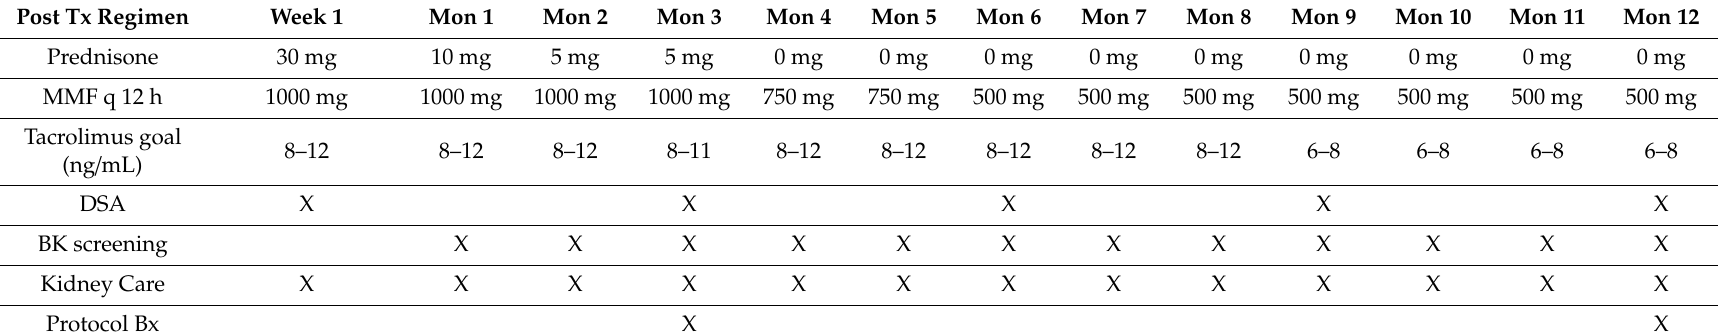
Table 3. Unblinded, two-armed interventional trial- Steroid minimization arm, first year post transplant.